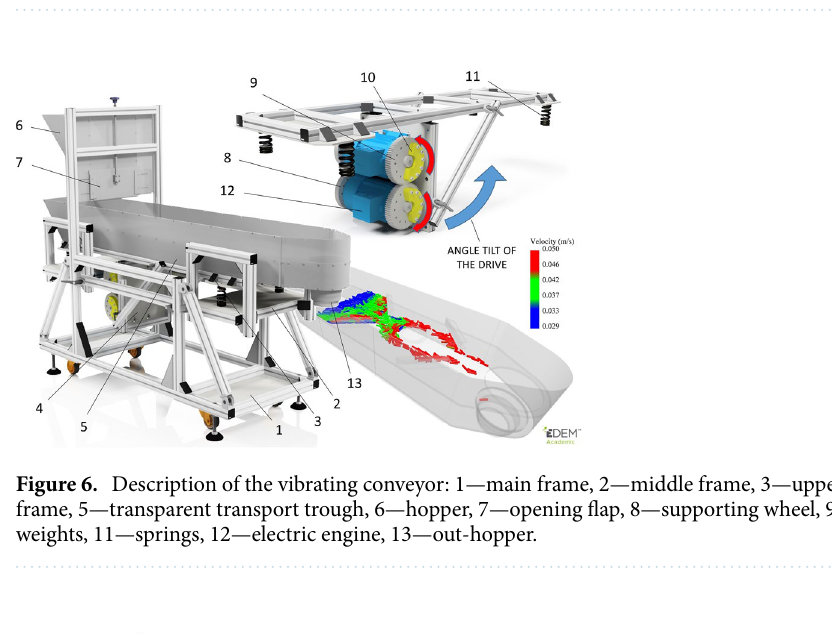
Figure 5. Schematic representation of a device for determining a dynamic angle of repose: 1—main frame, 2— electric gearbox, 3—frequency converter, 4—transparent drum, 5—transparent drum lid, 6—circular partition to reduce the volume of the drum, 7—pulleys, 8—screw connection.